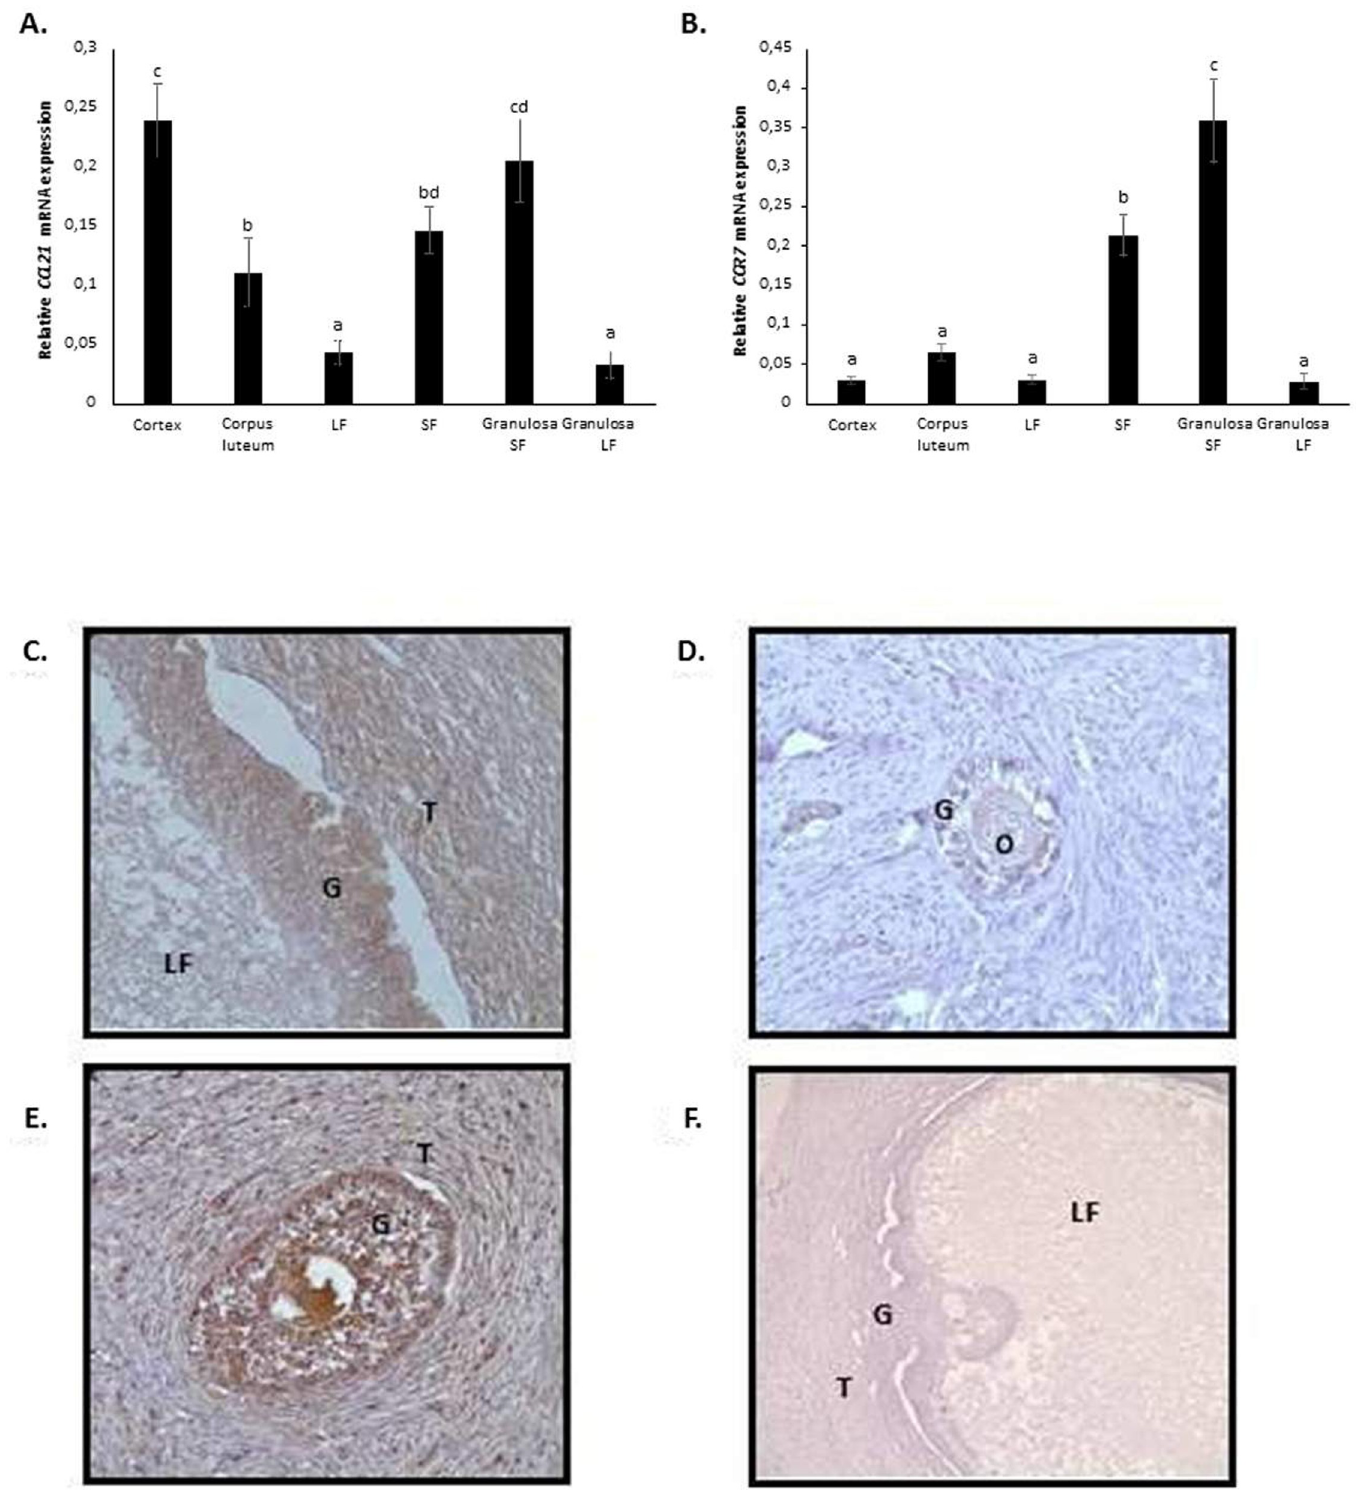
Fig 8. mRNA expression of CCL21 and its receptor CCR7 and protein localization of CCL21 in bovine ovary. The mRNA expression in ovarian cortex, corpus luteum, large follicles (LF), small follicles (SF), granulosa of large follicles and granulosa of small follicles was determined by RT-qPCR using specific bovine primers. The mRNA expression of CCL21 (A) and CCR7 (B) was normalized to geometric mean of three references genes ( UXT , SADH and PPIA ). Protein expression was determined by